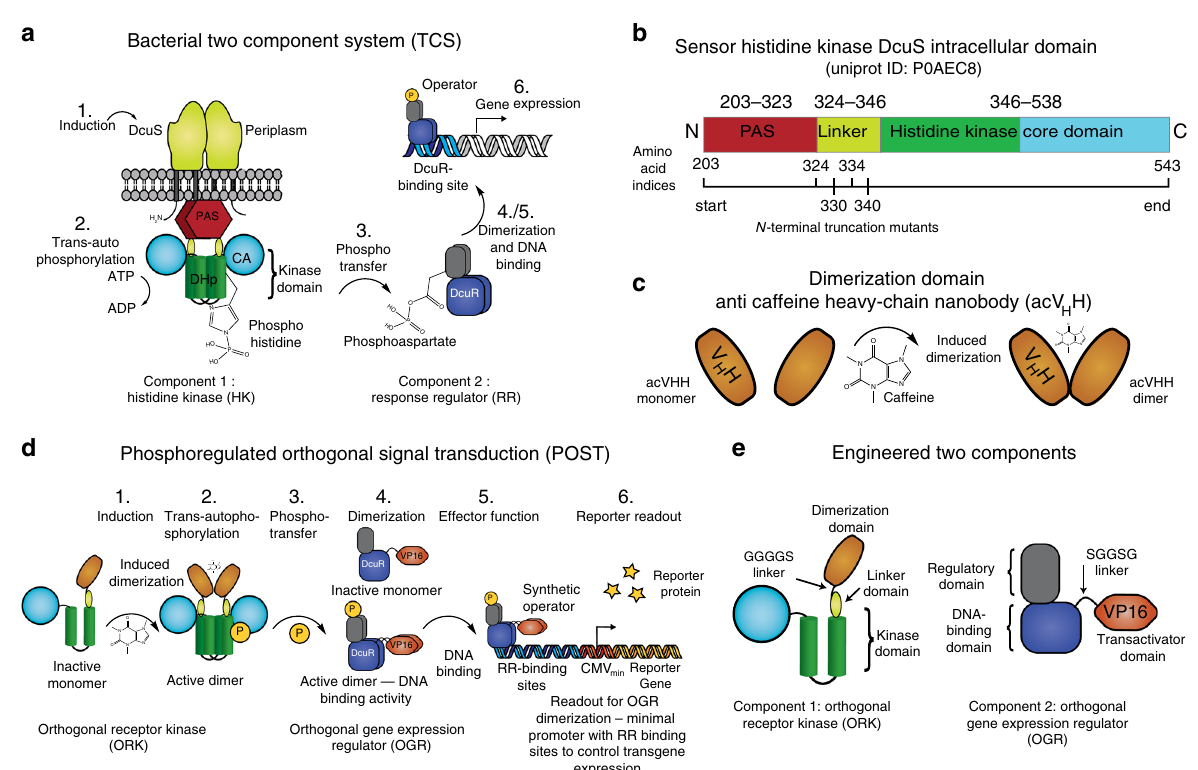
Fig. 1 Design of the phosphoregulated orthogonal signal transduction (POST) system. a Mechanism of the native signal cascade activated by the bacterial histidine kinase DcuS. (1) Upon activation, (2) the homodimeric histidine kinase DcuS trans-autophosphorylates a histidine residue in its kinase domain, consisting of the dimerization and histidine-containing phosphotransfer (DHp) domain and the catalytic and ATP-binding (CA) domain. (3) This phosphohistidine is the substrate for the response regulator DcuR that catalyzes the autophosphorylation of an aspartate residue in its dimerization domain. (4) Phosphorylated DcuR dimerizes and (5) binds response elements in its operator site to control (6) gene expression. b Linear schematic depiction of the N-terminal truncation constructs. The constructs start with the amino acid number indicated to the left and end with amino acid number 543 (numbered according to UniProt ID: P0AEC8). c The camelid heavy chain nanoboy acV H H dimerizes in the presence of caffeine. d Schematic illustration of the POST system design. (1) Caffeine induces dimerization of acV H H domains in the engineered orthogonal receptor kinase (ORK), causing (2) kinase trans autophosphorylation and (3) phosphotransfer to an engineered effector protein, such as the orthogonal gene expression regulator (OGR). (4) The effector dimerizes upon phosphotransfer to perform its function, i.e., DNA binding (5), leading to (6) activation of gene expression. e Detailed design of ORK and OGR proteins. The regulatory domain catalyzes the transfer of the phosphoryl group from phosphohistidine to one of its own aspartate residues and subsequently dimerizes.